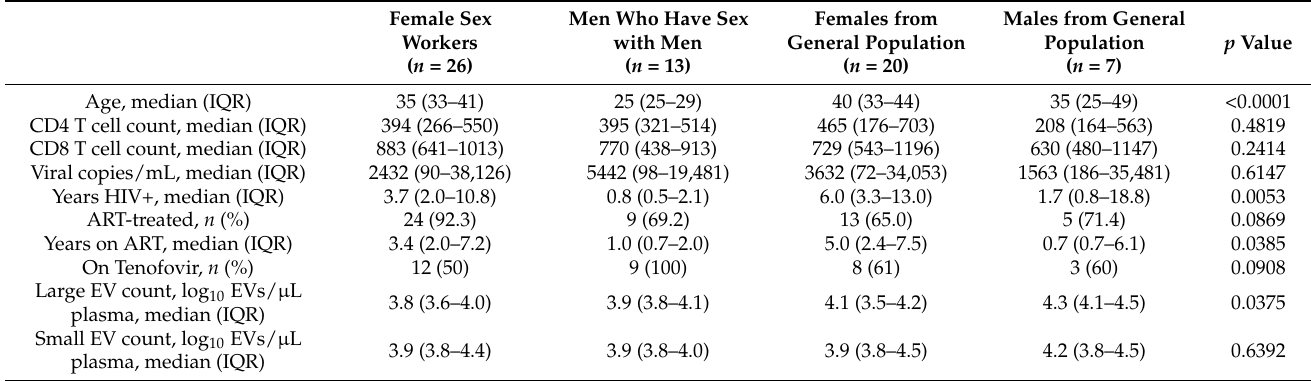
Table 3. Characteristics of viremic participant subgroups.